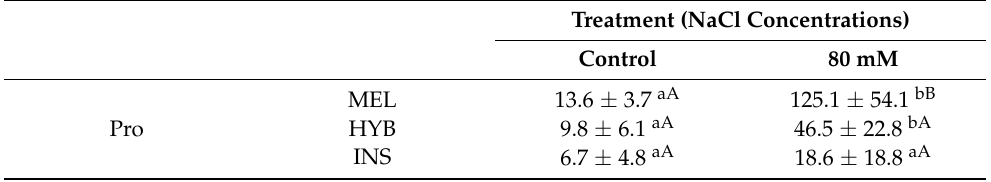
Table 6. Proline (Pro) values ( µ mol g − 1 dry weight) (mean ± SD; n = 5) in adult plants of Solanum melongena (MEL), Solanum insanum (INS) and their hybrid (HYB) in control conditions and under long-term (eight weeks) 80 mM NaCl irrigation. Different lowercase letters within the same row indicate statistically significant differences between treatments, and different uppercase let- ters within the same column indicate statistically significant differences between genotypes ( p < 0.05), according to the Student–Newman–Keuls multiple range